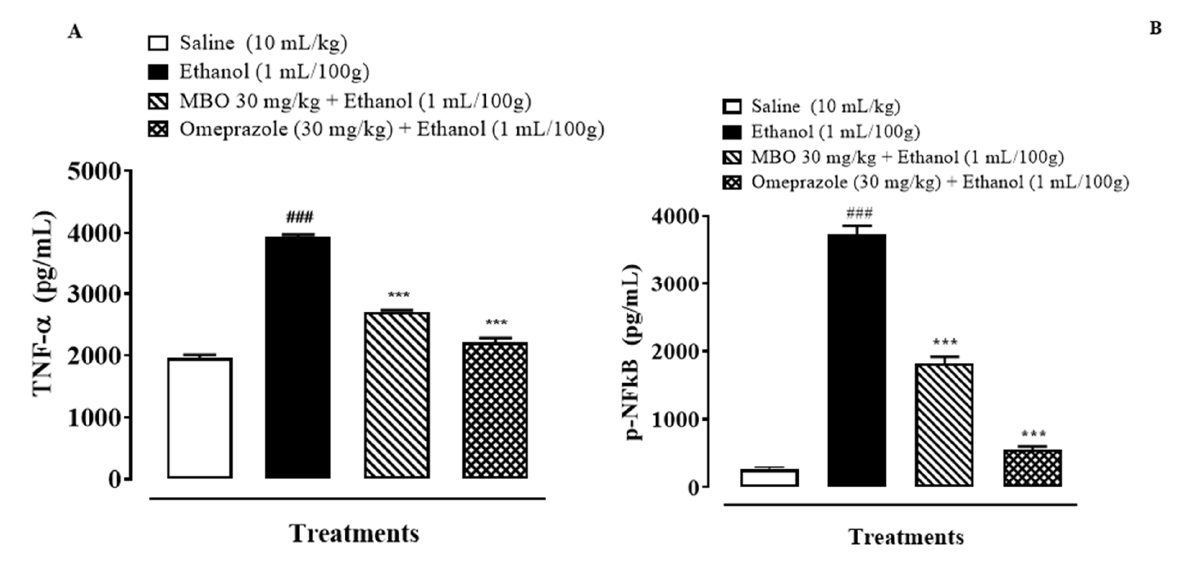
Figure 7. ( A , B ) represents effect of MBO on TNF-α and p-NFkB expression in gastric tissue of rats. After 1 h of ethanol treatment, animals were sacrificed; stomachs were isolated and stored at −80 °C. Stomach tissues were homogenized as described in the methods section, and TNF-α and p-NFkB levels were measured by ELISA assay. Values expressed as mean ± SEM ( n = 3). *** p < 0.001; ### p < 0.001. Analyzed by one-way ANOVA followed by posthoc Tukey’s test.